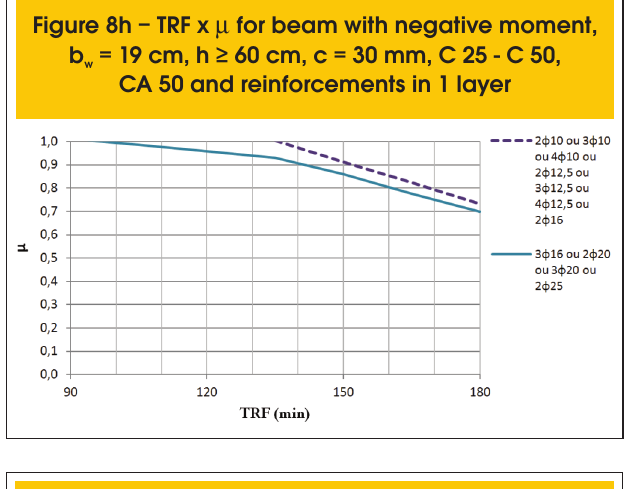
Figure 8i – TRF x m for beam with negative moment, b = 19 cm, h ≥ 60 cm, c = 40 mm, C 25 - C 50, w